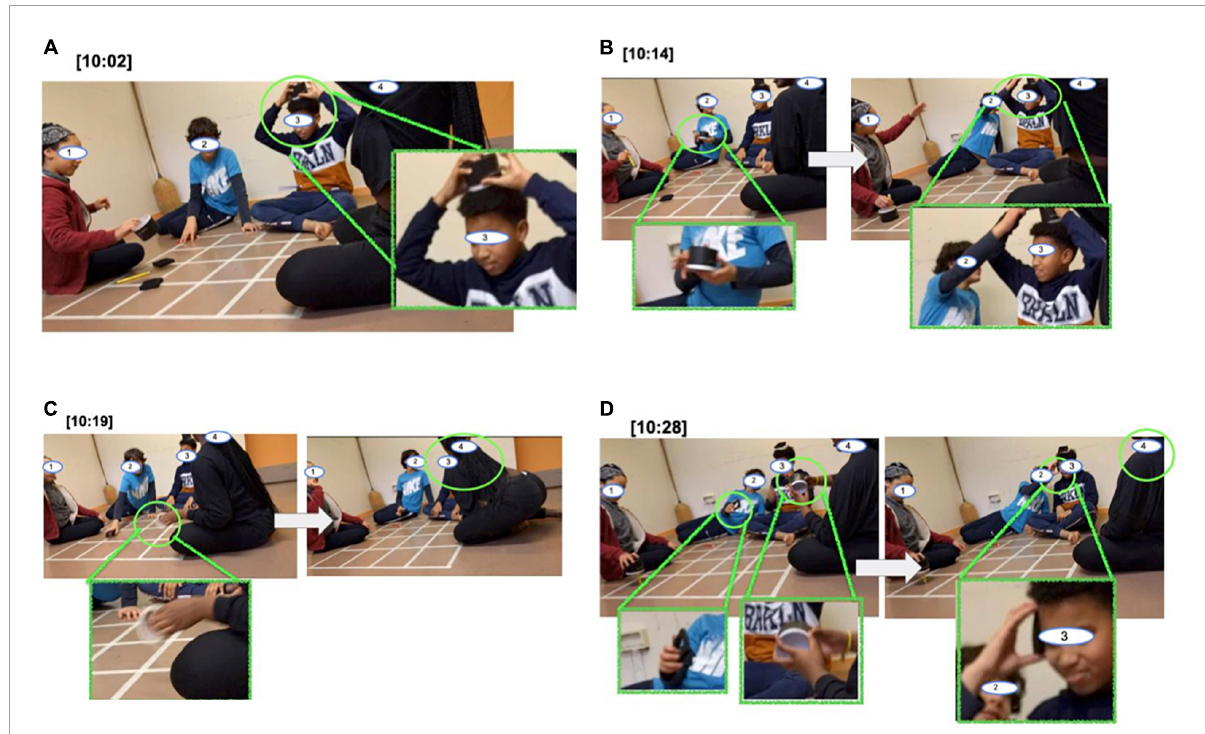
FIGURE7 Example of the activation of a dimension. (A) Player 3 places a round box on his head. (B) Player 2 places a second box on top of the first one. (C) Player 4 places the roll of tape on top of the two boxes. (D) Player 2 hangs the flat square on the ear of player 3 while player 4 places a box on top of her own